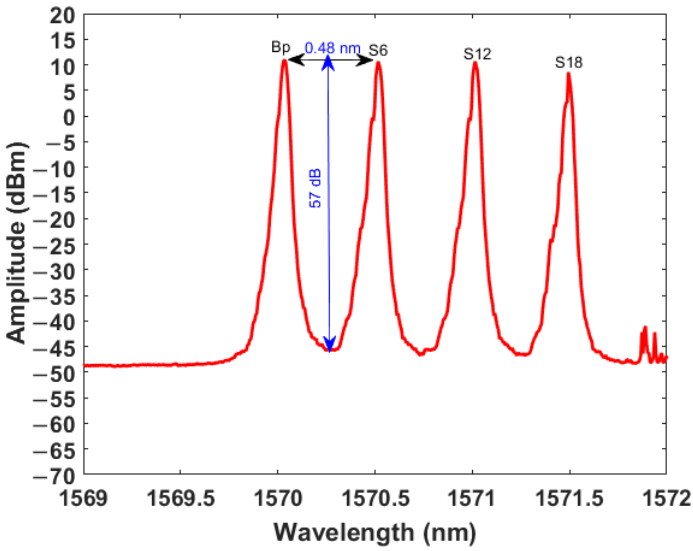
Figure 4. The output spectrum of the sextuple Stokes signals at the optimal input parameters.